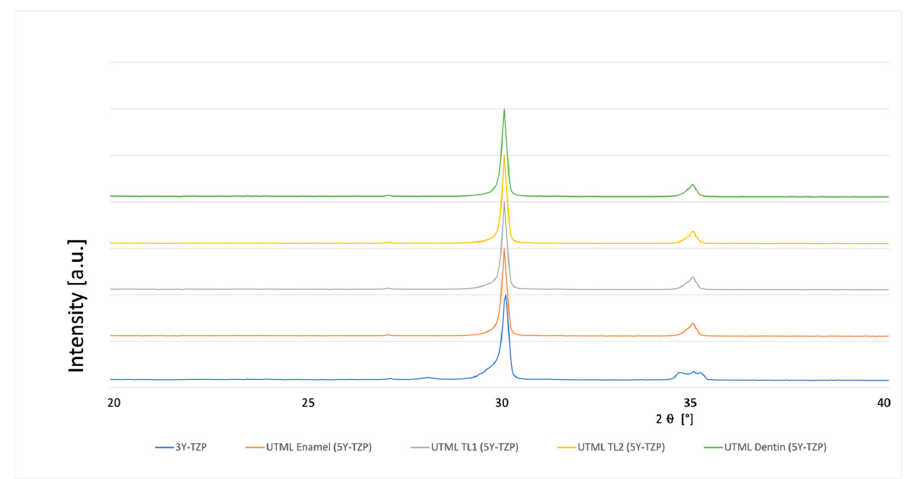
Figure 4. XRD analysis 3Y-TZP and 5Y-PSZ 1 µm polished and fully sintered before cutting.